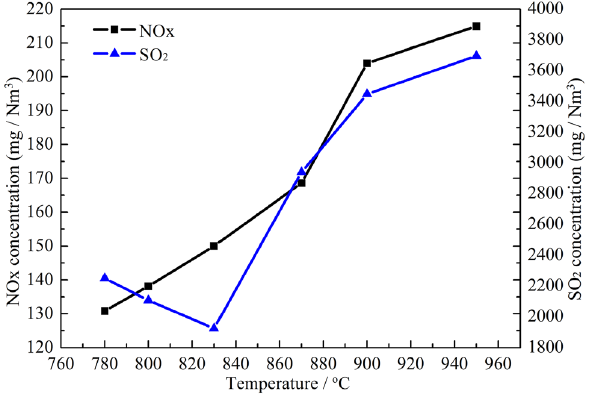
Fig. 3 Effect of bed temperature on the NO x and SO 2 emissions